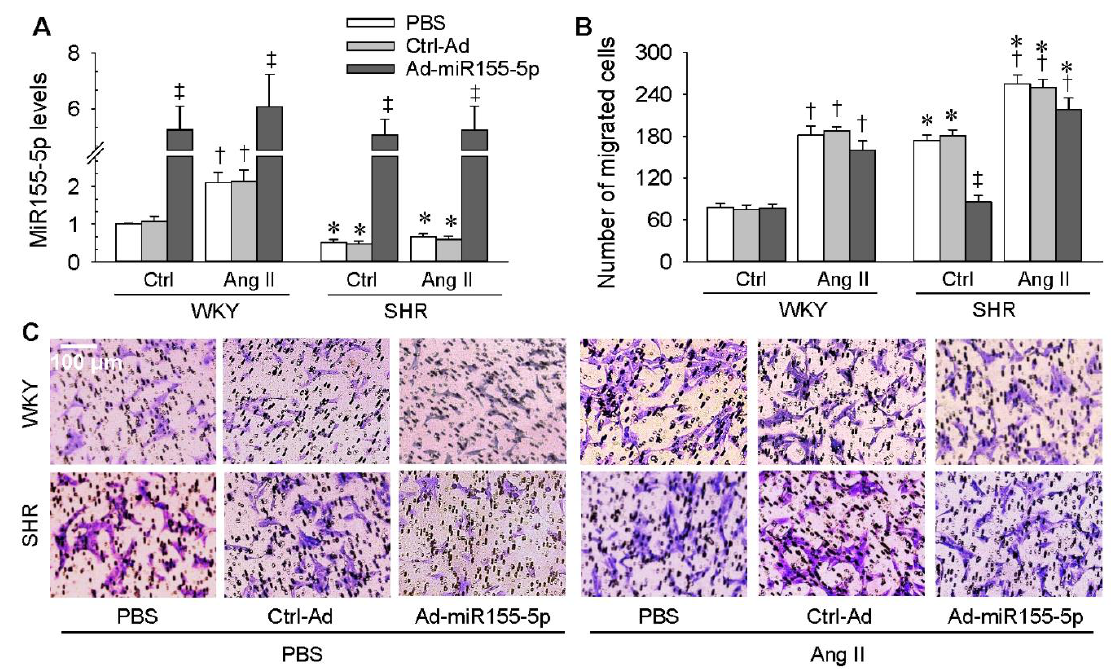
Figure 6. Effects of miR155-5p overexpression on angiotensin II (Ang II)-induced VSMC migration. VSMCs of WKY rats and SHR were treated with PBS, control adenovirus (Ctrl-Ad), or miR155-5p adenovirus (Ad-miR155-5p, 40 MOI) for 24 h, followed by PBS or Ang II treatment (100 nM) for another 24 h. ( A ) miR155-5p levels in VSMCs; ( B,C ) VSMC migration evaluated by the Boyden chamber assay. Values are mean ± SE; * p < 0.05 vs. WKY; † p < 0.05 vs. Ctrl; ‡ p < 0.05 vs. PBS or Ctrl-Ad; n = 6 per group.